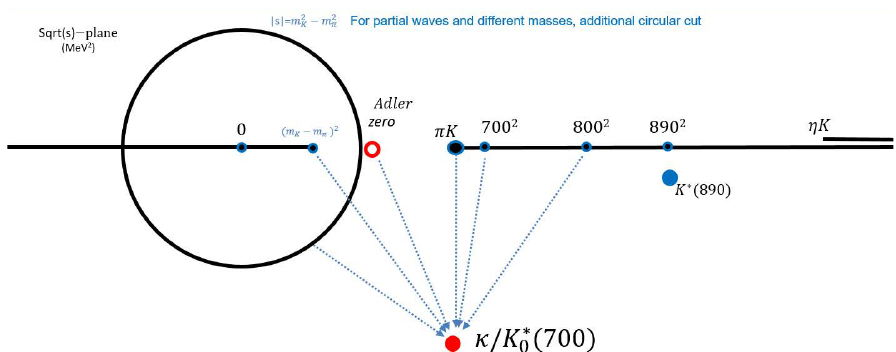
Figure 2. The analytic structure of π K partial waves has physical cuts on the real axis extending from each new threshold to infinity, a circular cut and a left cut due to crossed channels. The presence of an Adler zero in the subthreshold region is a requirement of chiral symmetry breaking. For typical Breit- Wigner-like resonances like the K ∗ (892), their associated pole in the lower half of the complex plane (in blue) lies close to the real axis very near its nominal mass. In contrast, the κ/ K ∗ lies very deep in the complex plane. Moreover, its pole is as close to its nominal mass region in the real axis as it is to the π K threshold, the Adler zero, the circular and left cuts. For a precise determination of the κ/ K ∗ (700) pole a careful calculation of such contributions is thus 0